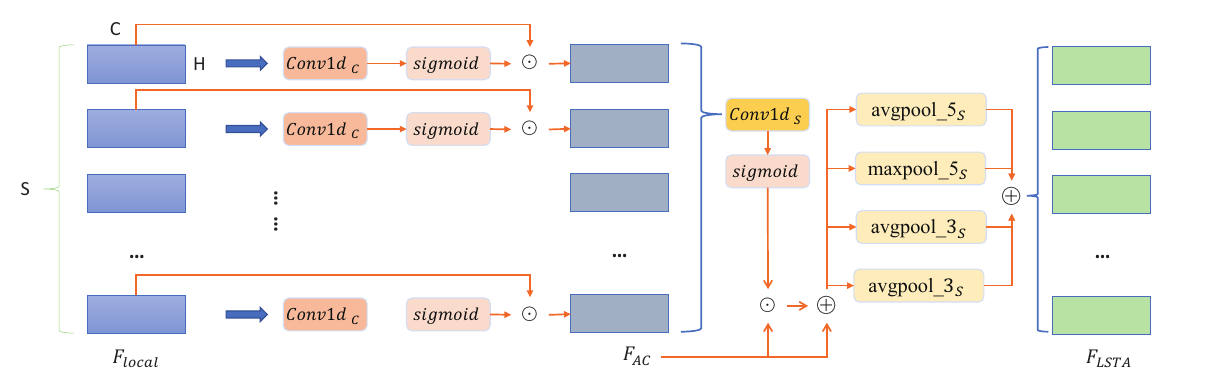
Figure 2. The overview structure of the